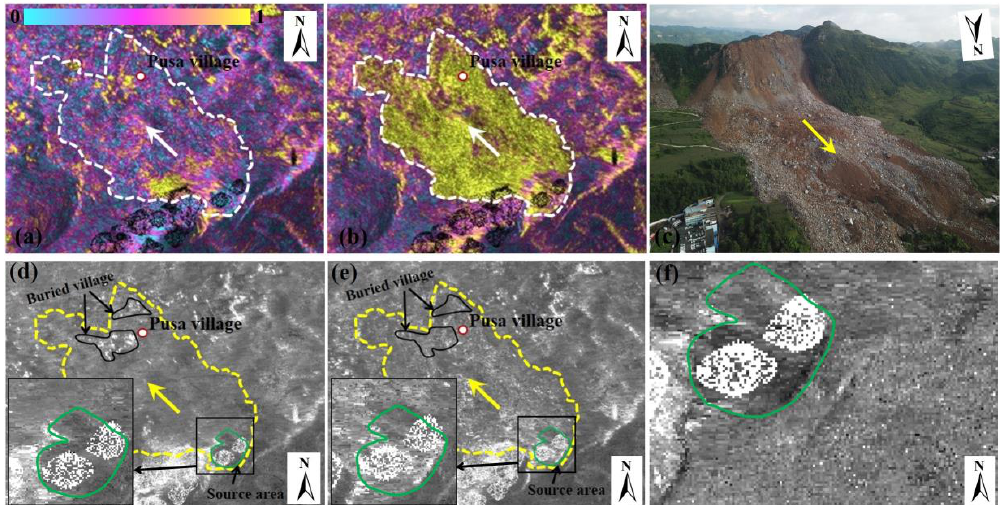
Figure 6. The boundary and source area of the Pusa landslide identified by coherence and intensity maps from ALOS/PALSAR-2 images. ( a ) The pre-event coherence map, ( b ) the post-event coherence map, ( c ) the on-site image after landslide occurred, ( d ) and ( e ) the pre- and post-event SAR intensity maps acquired on 6 August 2017 and 12 November 2017, respectively, ( f ) the ratio between ( d ) and ( e ). It is noted that the color shown in ( a ) and ( b ) represent the coherence value. The white and yellow dash lines represent the landslide boundary, while the green line shows the source area. The black polygon shown in ( d ) and ( e ) represents the buried villages. polygon shown in ( d ) and ( e ) represents the buried